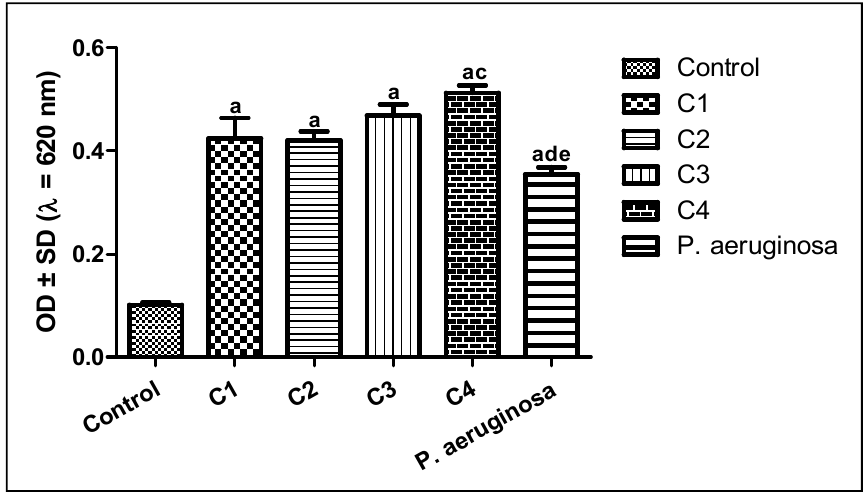
Figure 4. Results of biofilm formation of P. aeruginosa . Isolates were classified as negative (OD ≤ ODc), weak (ODc ≤ OD ≤ 2ODc), moderate (2ODc < OD ≤ 4ODc), and strong biofilm production (4ODc < OD). OD = optical density. a Significant compared to control at p < 0.05. b Significant compared to C1 at p < 0.05. c Significant compared to C2 at p < 0.05. d Significant compared to C3 at p < 0.05. e Significant compared to C4 at p < 0.05.